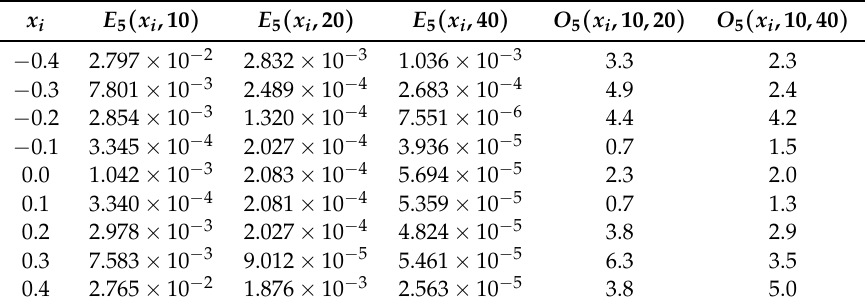
Table 13. The absolute errors of the fifth order derivatives of y 2 at the knots and the numerical convergence orders.